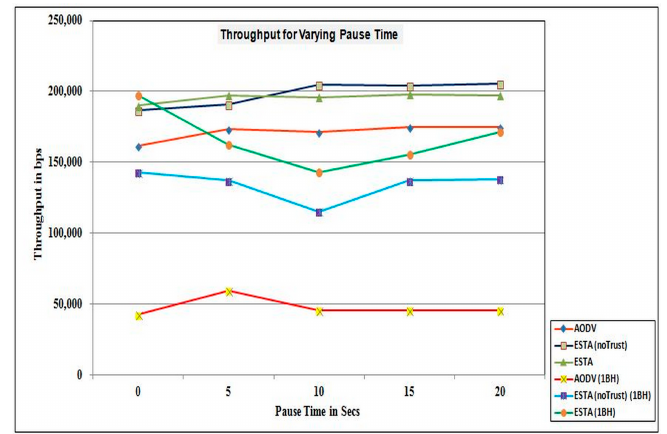
Figure 9. Throughput for varying pause